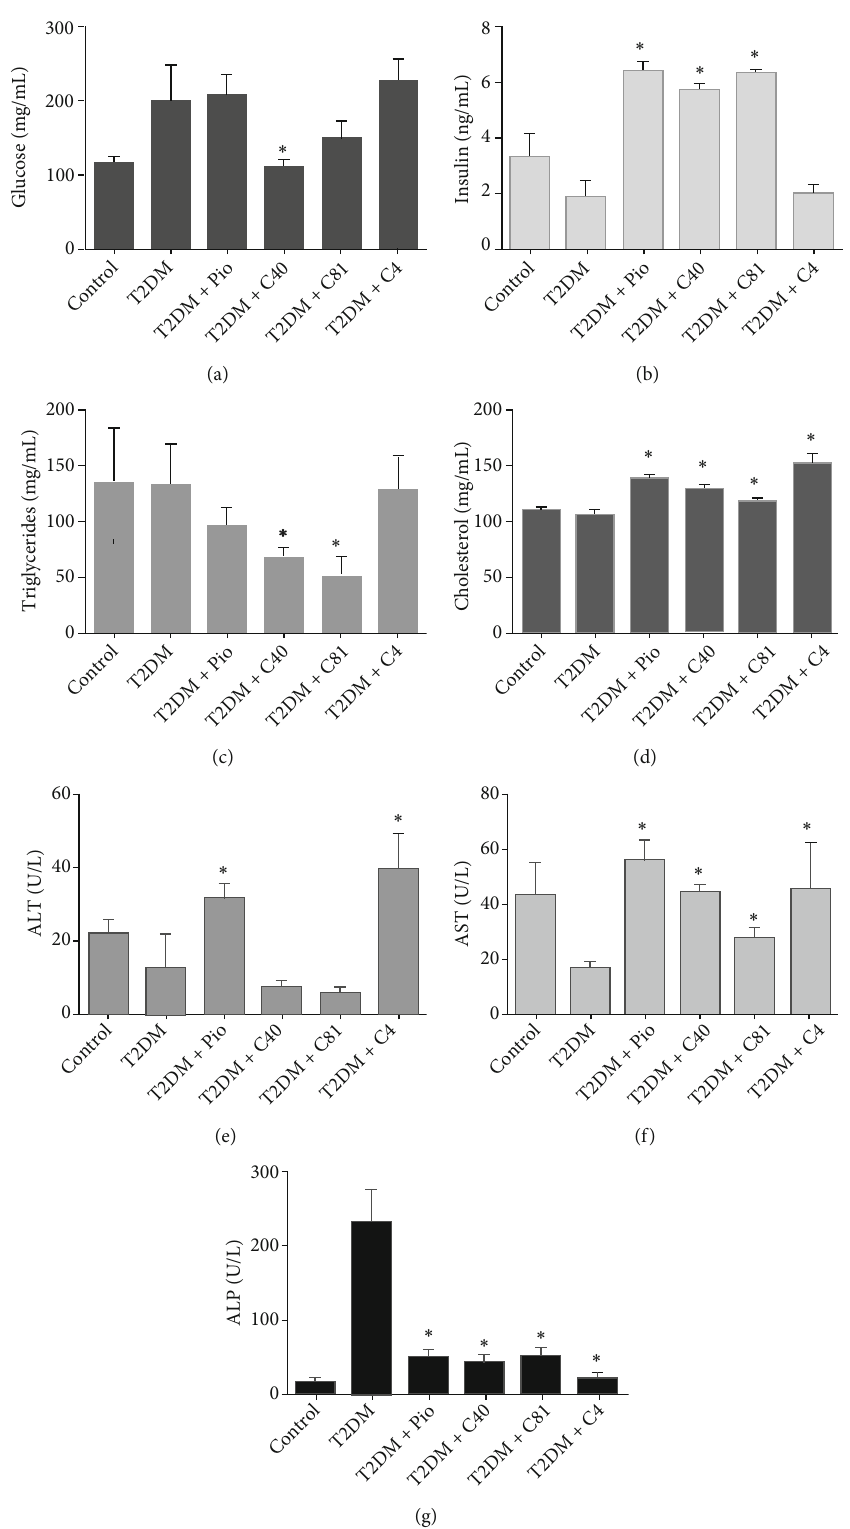
Figure 2: Metabolic parameters of the di ff erent groups ( n = 7 ): (a) glucose (mg/dL), (b) insulin (ng/mL), (c) triglycerides (mg/dL), (d) cholesterol (mg/dL), (e) ALT (U/L), (f) AST (U/L), and (g) ALP (U/L). ∗ p ≤ 0 : 01 vs. the untreated diabetic group (T2DM). Pio: